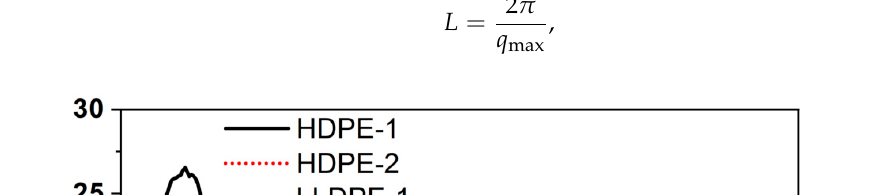
where z is the correlation distance along the direction from which the electron density distribution is measured. The average long spacing ( L ), the average crystalline phase thickness ( L c ) and the average non-crystalline phase thickness ( L a ) can be calculated from the correction function. The correlation functions of different types of PE are shown in Figure 4, and the obtained structural parameters are listed in Table 3. The L c of the HDPE resins (20.1 nm for HDPE-1 and 16.5 nm for HDPE-2) were much higher than that for the neat LLDPE (5.3 nm for LLDPE-1 and 5.7 nm for LLDPE-2) and LDPE (4.9 nm), as the linear PE molecules in HDPE formed a thicker lamella than the branched ones in LLDPE and LDPE, resulting in a significantly higher melting